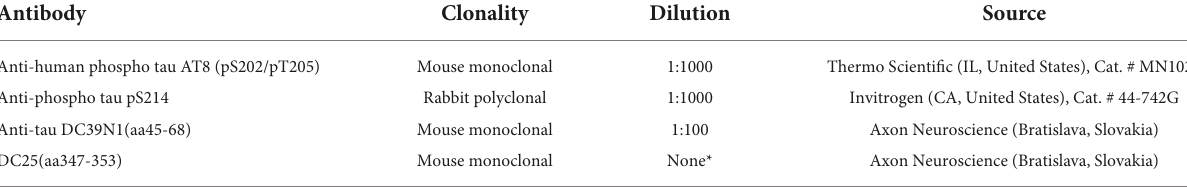
TABLE 2 List of antibodies used for Immunohistochemical staining.